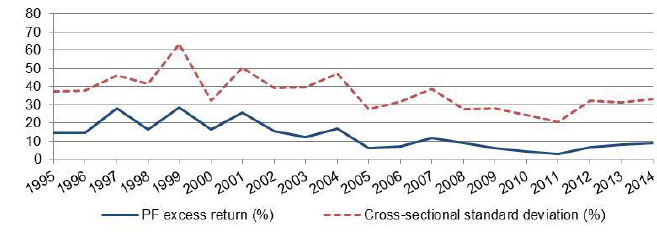
Figure 4: Mid Cap segment PF excess return and cross- sectional standard deviation